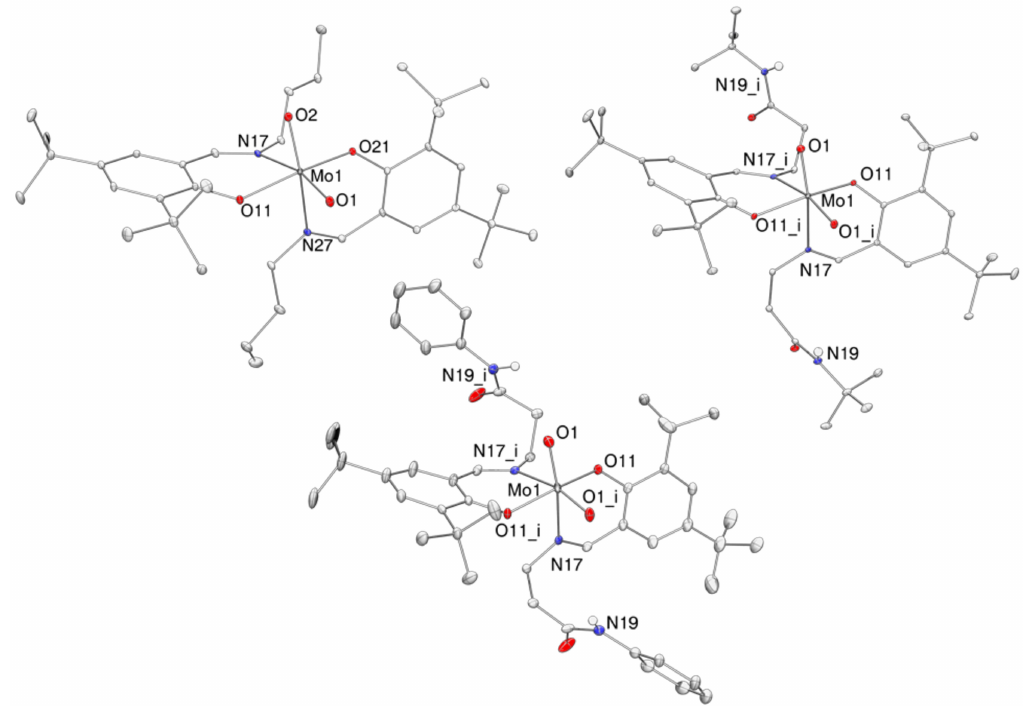
Figure 3. Molecular views (50% probability level) of the dioxidomolybdenum(VI) complexes [MoO 2 ( L1 ) 2 ] 15 ( 1 , top left), [MoO 2 ( L2 ) 2 ] ( 2 , top right) and [MoO 2 ( L3 ) 2 ] ( 3 , bottom). H atoms, except amide protons, as well as solvent molecules are omitted for clarity reasons.